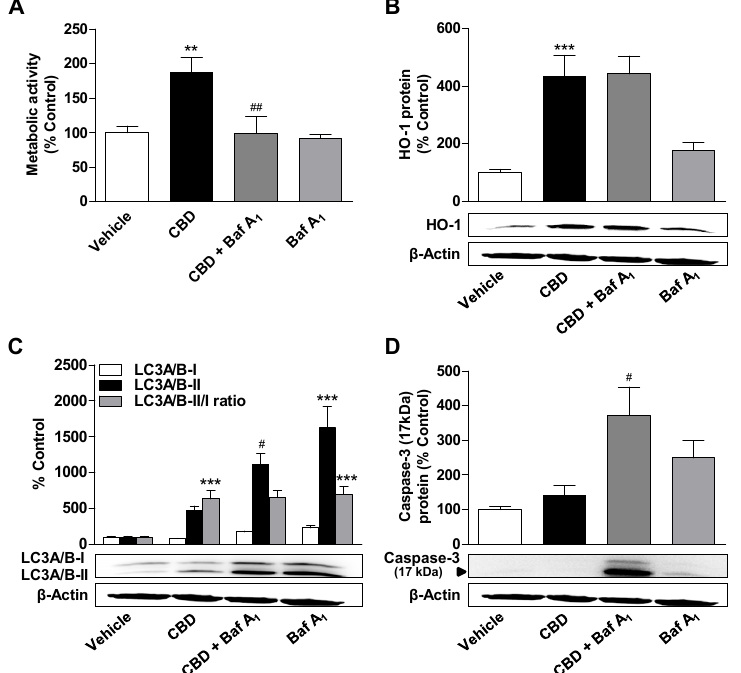
Figure 5. Influence of the autophagy inhibitor bafilomycin A 1 (Baf A 1 ) on the e ff ects of CBD on metabolic activity, autophagy, apoptosis, and HO-1 expression. ADMSCs were pretreated for 30 min with bafilomycin A 1 (100 nM) and after subsequent addition of CBD (3 µ M) or vehicle, the cells were co-incubated with the substances or vehicles for 24 h. Afterwards, the cells were analyzed for metabolic activity ( A ), HO-1 ( B ), and LC3A/B-I/II ( C ) expression as well as caspase-3 cleavage ( D ). The protein expression values were normalized to β -actin. The same actin blot was used as control in ( B – D ), since the proteins analyzed in these Western blots were resolved on the same gel. The percentage control provides a comparison with the vehicle-treated group (set to 100%). The data represent mean values ± SEM of n = 9 ( A ), n = 10 ( B , C ), and n = 5 ( D ) different donors. ** p < 0.01, *** p < 0.001 vs. vehicle control; # p < 0.05, ## p < 0.01 vs. CBD; one-way ANOVA with Bonferroni’s post hoc test.